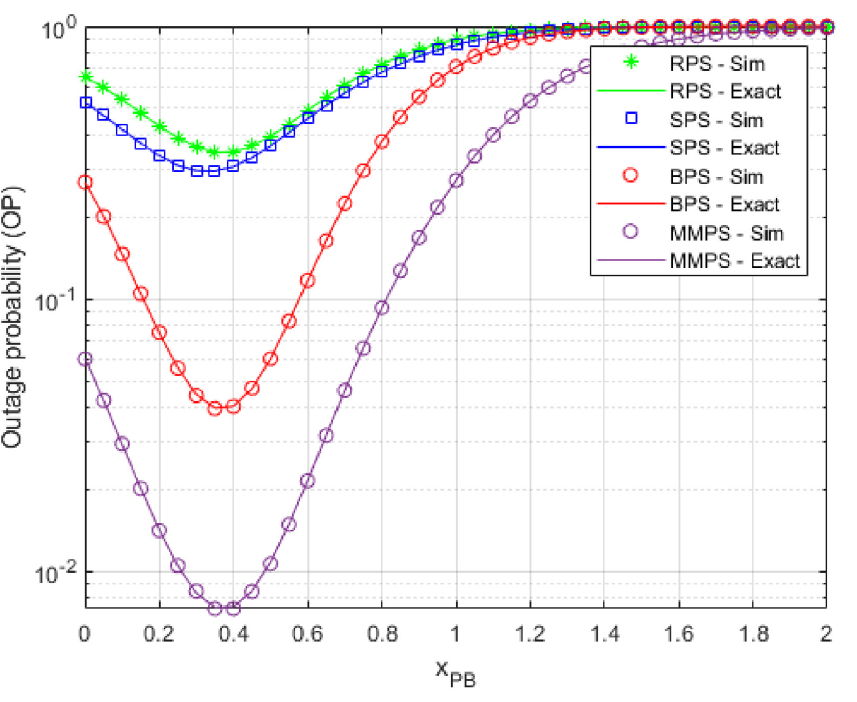
Fig 5. OP as a function of x